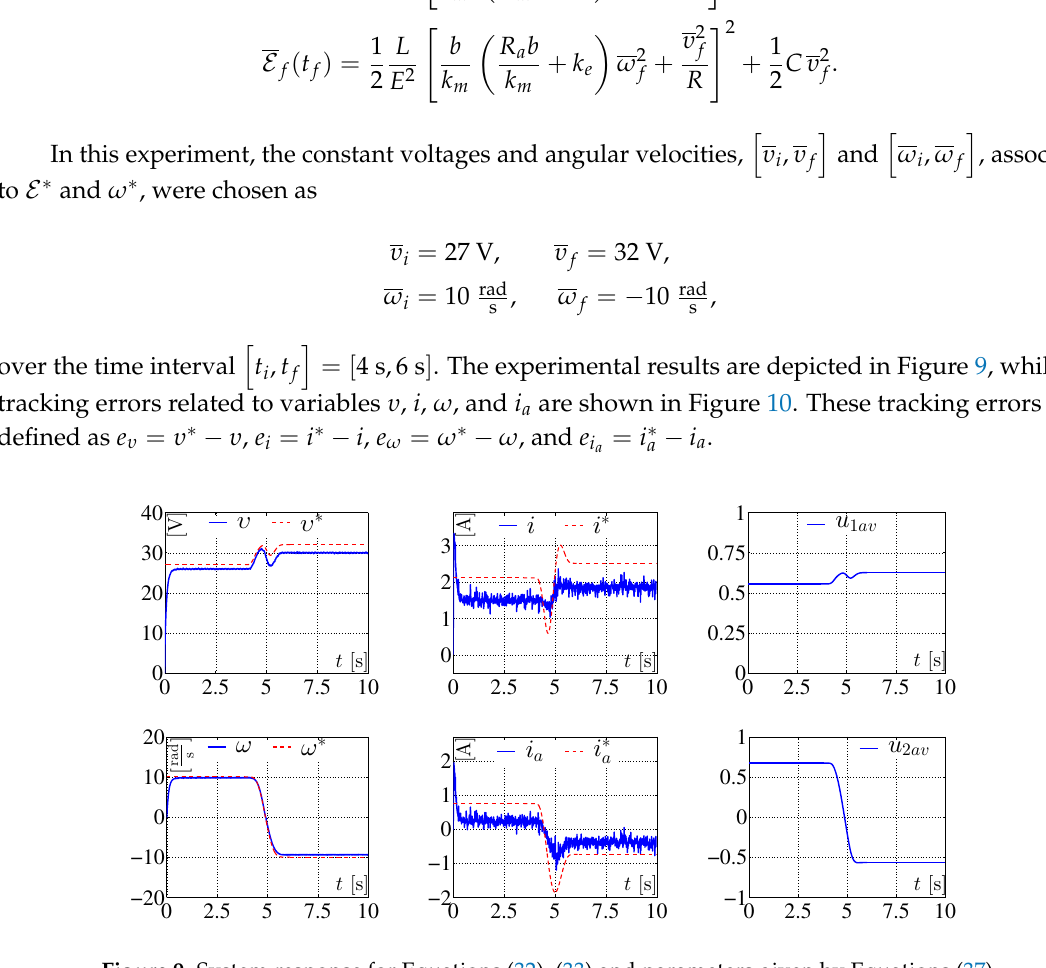
Figure 9. System response for Equations (32)–(33) and parameters given by Equations (37).